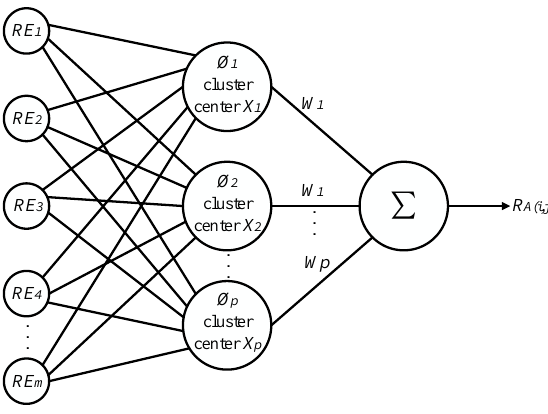
Figure 4. The network topology of the radial basis function (RBF) neural network.